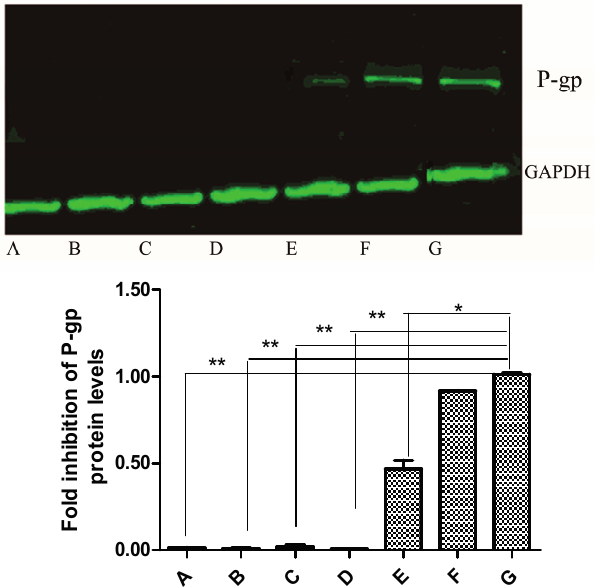
Figure 6. Effect of NCB on P-gp protein expression in MDCK and MDCK-hMDR1 cells. Whole-cell extracts were analyzed by Western blot with a specific anti-P-gp antibody. The upper arrow indicates P-gp protein, and the lower one indicates the endogenous GAPDH protein. A, B, C, D, E, F and G refer to different protein samples: A, MDCK cells incubated with HBSS (negative control); B, MDCK-hMDR1 cells incubated with NCB (80 μ M); C, MDCK-hMDR1 cells incubated with NCB (40 μ M); D, MDCK-hMDR1 cells incubated with NCB (20 μ M); E, MDCK-hMDR1 cells incubated with NCB (10 μ M); F, MDCK-hMDR1 cells incubated with Vera (100 μ M); G, MDCK-hMDR1 cells